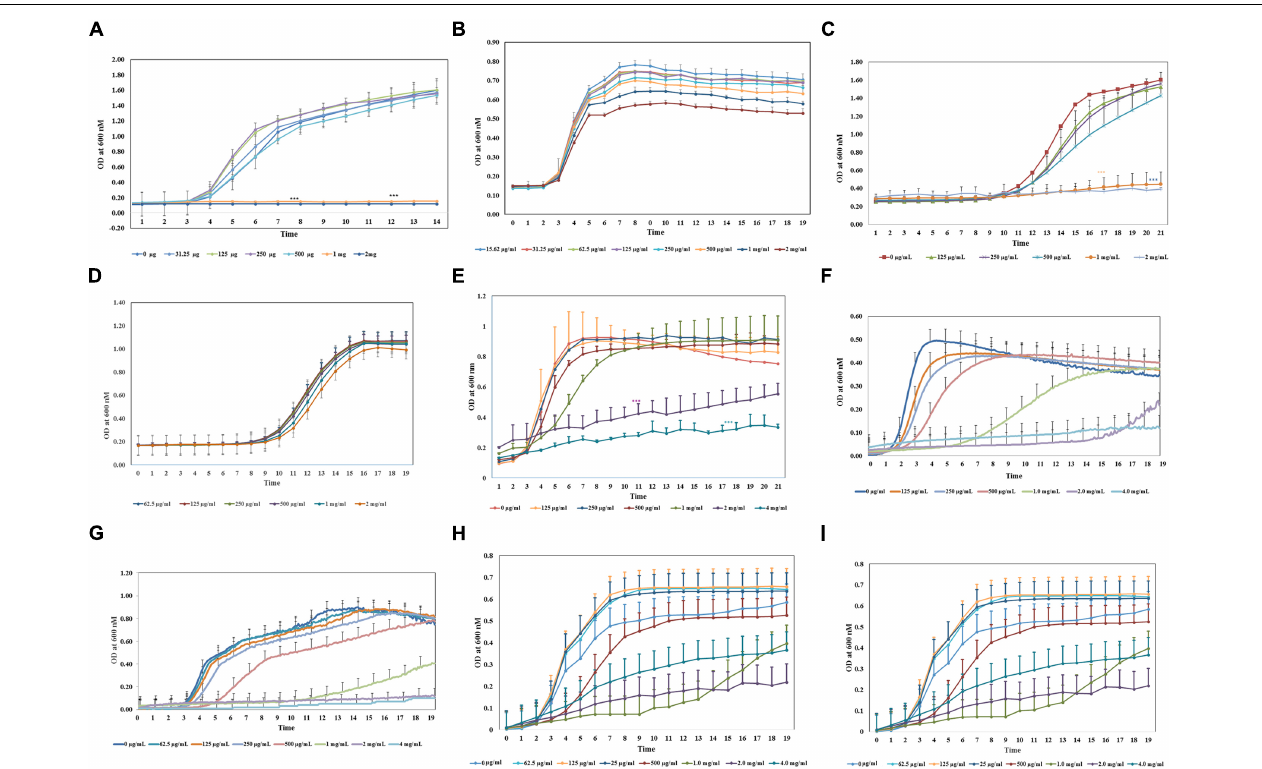
FIGURE 1 | Antimicrobial property of aloin on in vitro cultured bacterial species. All bacterial cultures were incubated with two-fold serial dilution of aloin starting a concentration of 2 mg/ml to 0.03 µ g/ml (A–D) or 4g/ml to 0.015 µ g/ml (E–I) . The data presented here were average of five independent experiments. Values of p < 0.05 or below indicated as a statistical significance compared to control group or among the experimental groups. Asterisks indicates statistical significance ( ∗ p < 0.05, ∗∗ p < 0.01, ∗∗∗ p < 0.001). (A) E. coli J53 was grown under aerobic conditions. (B,C) L. acidophilus was grown under aerobic conditions or anaerobic conditions, respectively. Aloin was unable to kill L. acidophilus under anaerobic conditions. (D) B. longum was grown under anaerobic conditions. The figure shows that only higher concentration of aloin was able to decrease Bifidobacterium growth under anaerobic conditions. (E,F) E. faecium was grown under aerobic or anaerobic conditions, respectively. The figure shows that aloin was able to decrease E. faecium growth under aerobic conditions even at 4 mg/ml concentration but unable to prevent bacterial growth, however, aloin was able to kill E. faecium growth under anaerobic conditions. (G) B. thetaiotaomicron was grown under anaerobic conditions. The figure shows that aloin was able to kill B. thetaiotaomicron growth under anaerobic condition and the MIC value was 1 mg/ml. (H) A. muciniphila was grown under anaerobic conditions. The figure shows that aloin decreases A. muciniphila growth under anaerobic conditions. (I) Eubacteria sp. was grown under anaerobic conditions. The figure shows that aloin decreases Eubacterium sp. growth under anaerobic